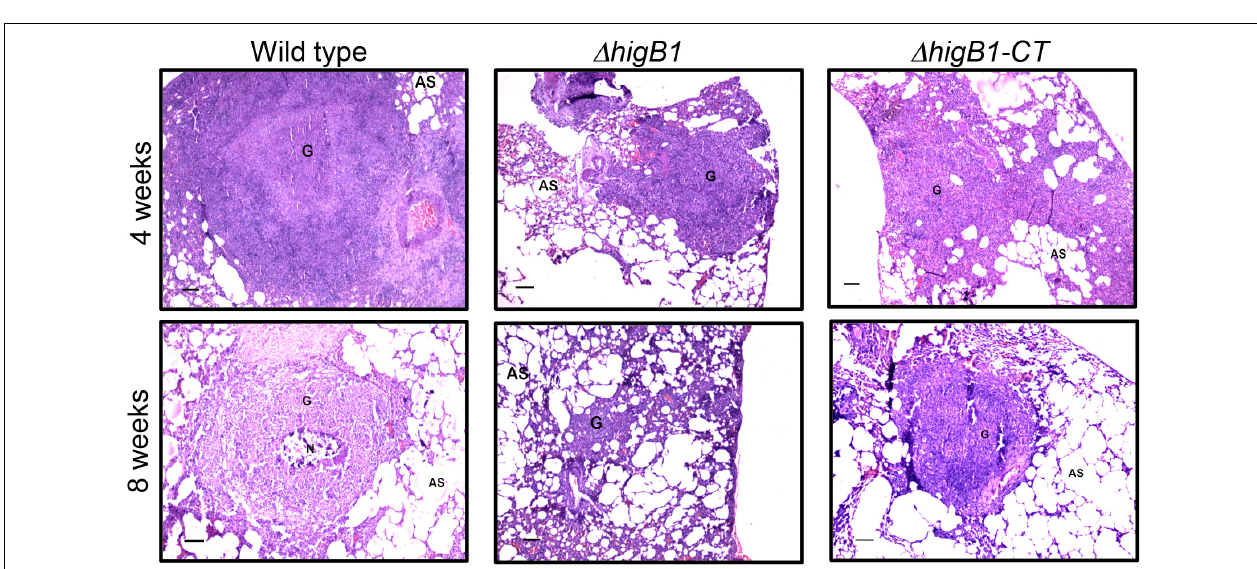
FIGURE 6 | Histopathological analysis of the lung sections obtained from the guinea pigs infected with various strains. The representative photomicrographs of the H&E stained sections (40x magnification) obtained from guinea pigs infected with various strains at 28- and 56-days post-infection. Scale bar – 100 microns.